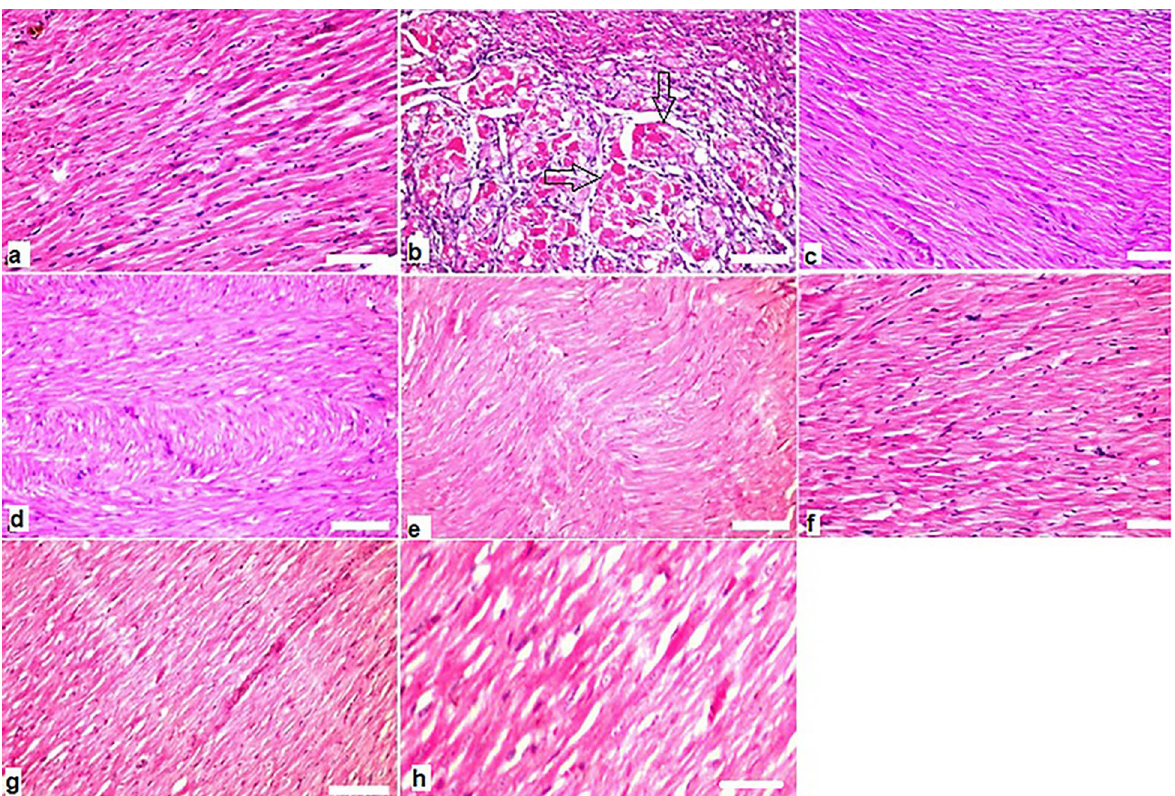
Figure 8. Histopathological findings in heart (a) showing normal histopathological structure of the myocardial bundles. (b) Focal degenerative changes with Zenkers necrosis (infarction) (arrows) (score 3) after exposure to gamma rays. (c) Irradiated rats were received of BV 0.05 mg/kg showed there was no histopathological alteration (score 0) as recorded in heart. (d) Irradiated rats were received of propolis 300 mg/kg showed there was no histopathological alteration (score 0) as recorded in heart. (e) Effect of combination treatment of propolis + BV 300 & 0.05 mg/kg respectively showed normal histological structure (score 0) in heart. (f,g) Effect of propolis 300 mg/kg and BV 0.05 separately respectively and (h) combined on the normal rats for two weeks without any alterations in heart. H&E stain